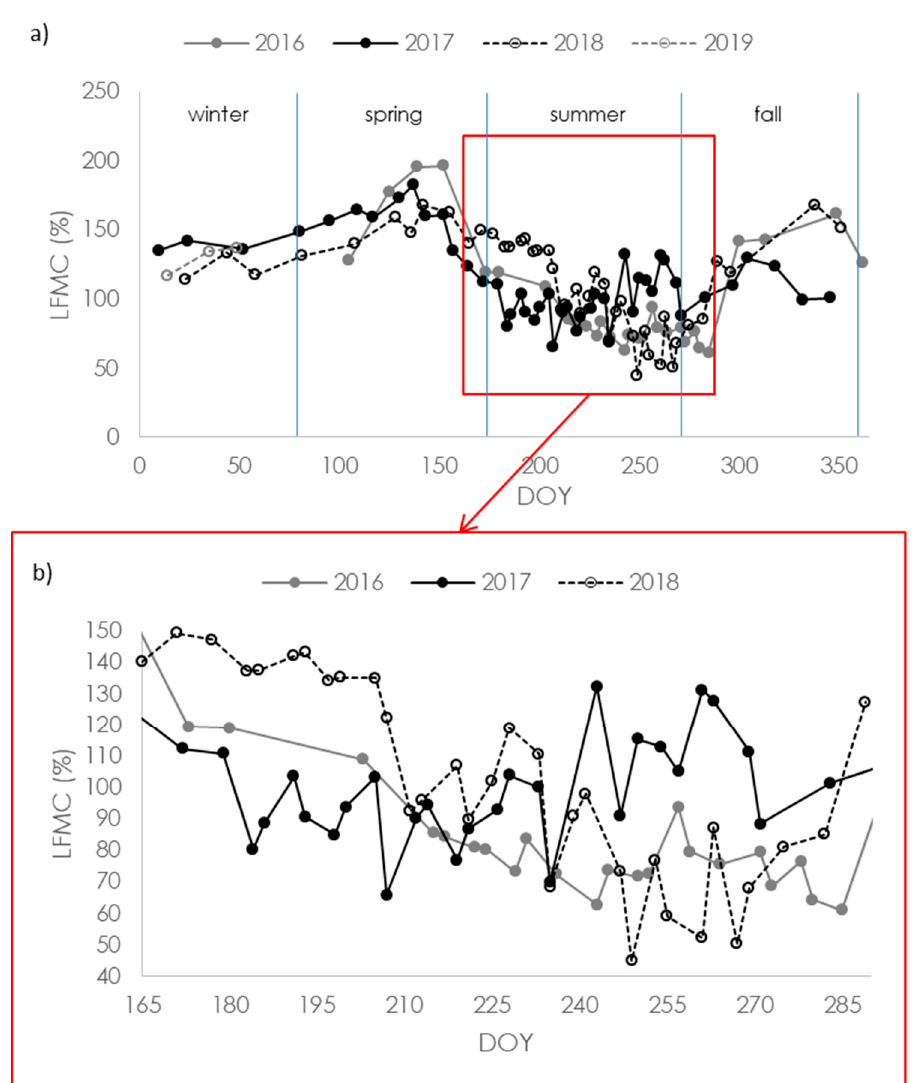
Figure 2. LFMC of C. ladanifer monitored in the field: ( a ) from April 2016 to February 2019 and ( b ) during the fire season (15 June (DOY = 166) to 15 October (DOY = 288)).